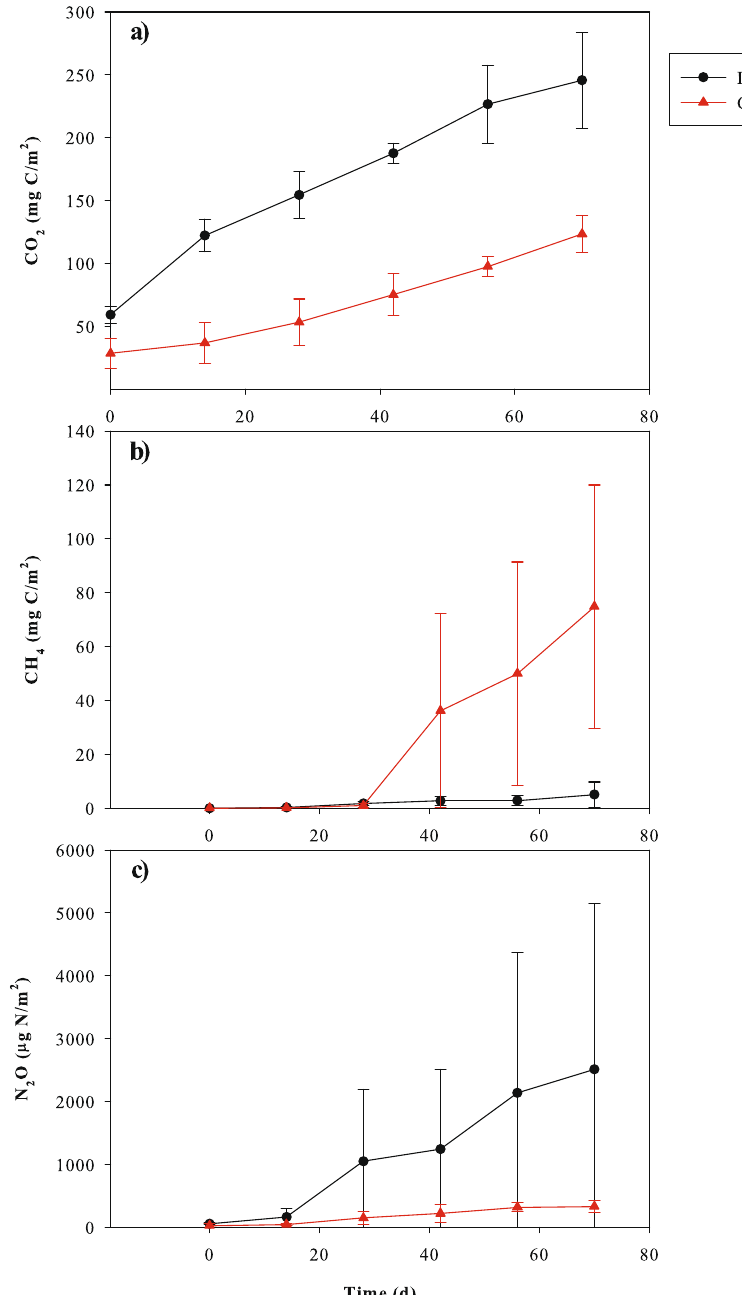
Fig. 4 Intermittent feeding and gaseous emission. Effect of intermittent feeding on ( a ) CO 2 , ( b ) CH 4 and ( c ) N 2 O emission. IMAVF Intermittently fed macrophyte assisted vermi fi ltration, CMAVF Continuously fed macrophyte assisted vermi fi ltration; Error bars: standard deviation created using replicated ( n = 3) set-ups for each experimental